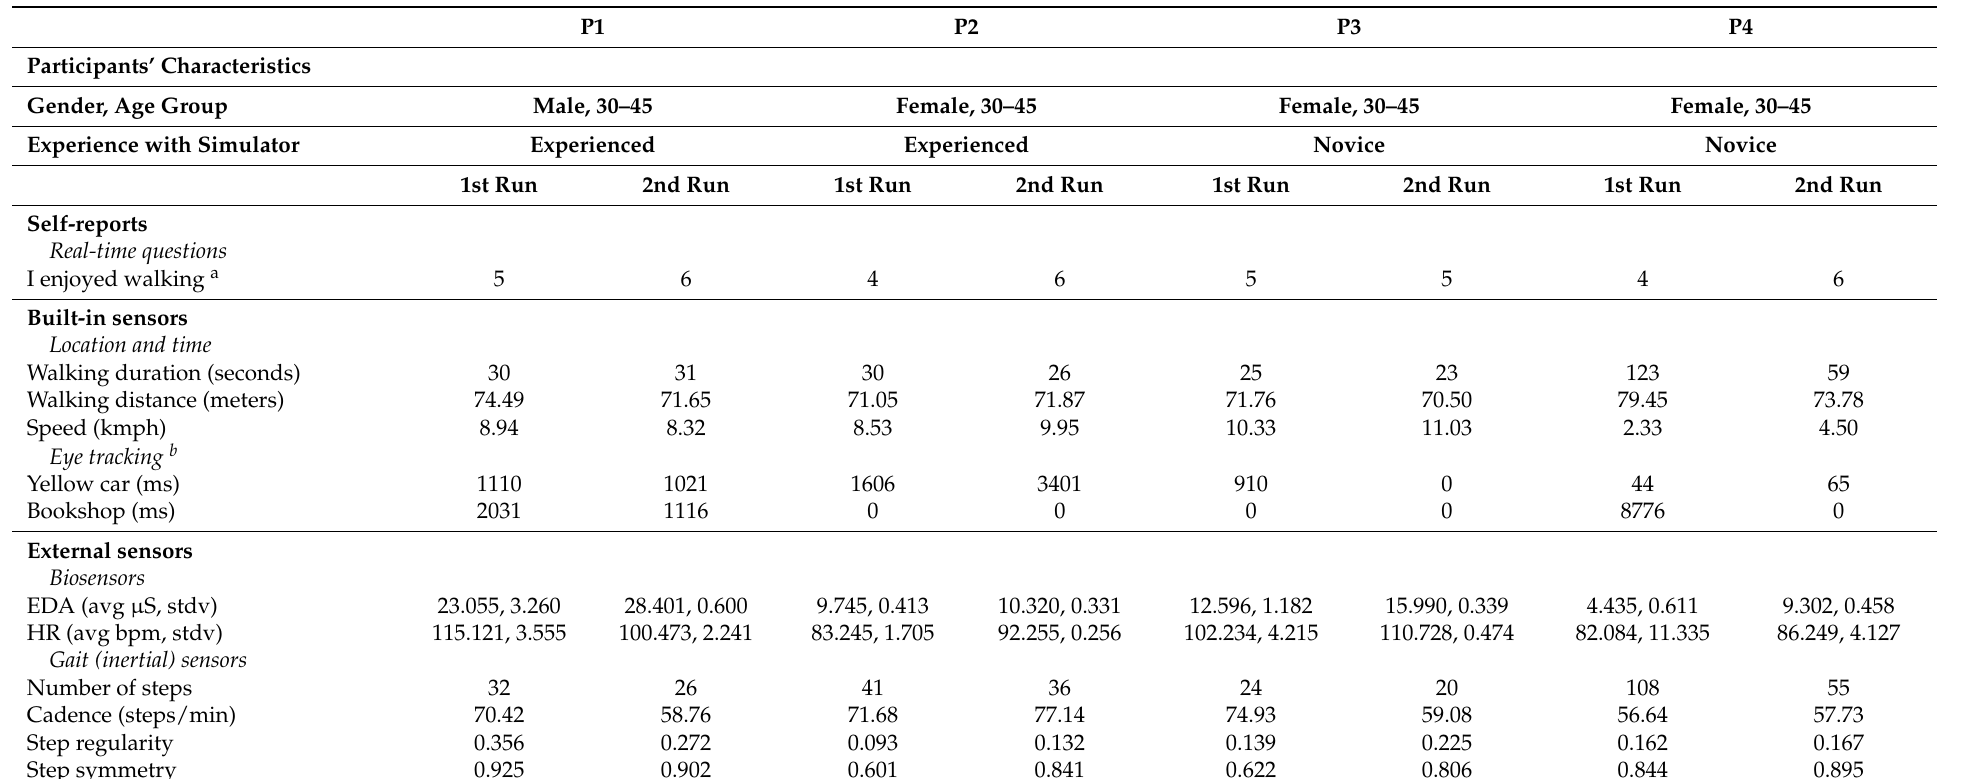
Table 1. Participants’ characteristics and per-run descriptive statistics of recorded